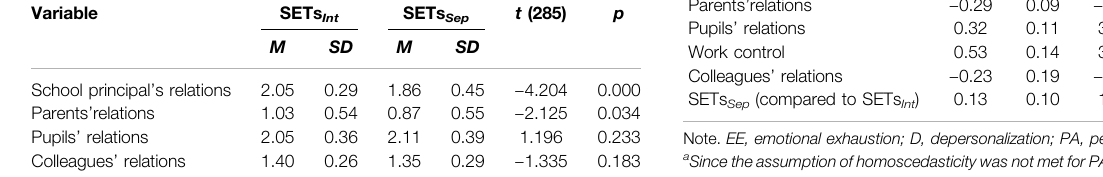
TABLE 11 | Comparison of collaborative variables means in the two subgroups.